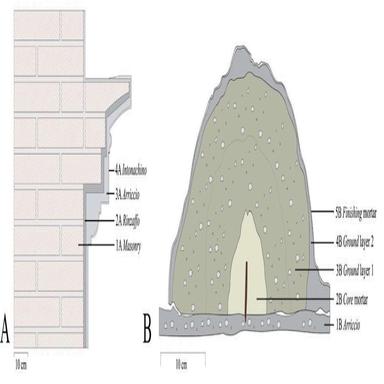
A. Graphical reconstruction of the stratigraphic sequence of the wall. B. Graphical reconstruction of the mortars' stratigraphy of the detached fragment, detail of the eagle body. Definitions in.